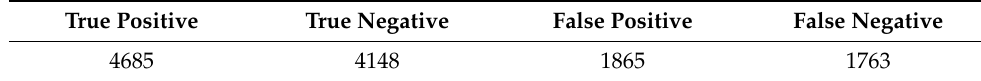
Table 4. Comparison between human and Mazajek